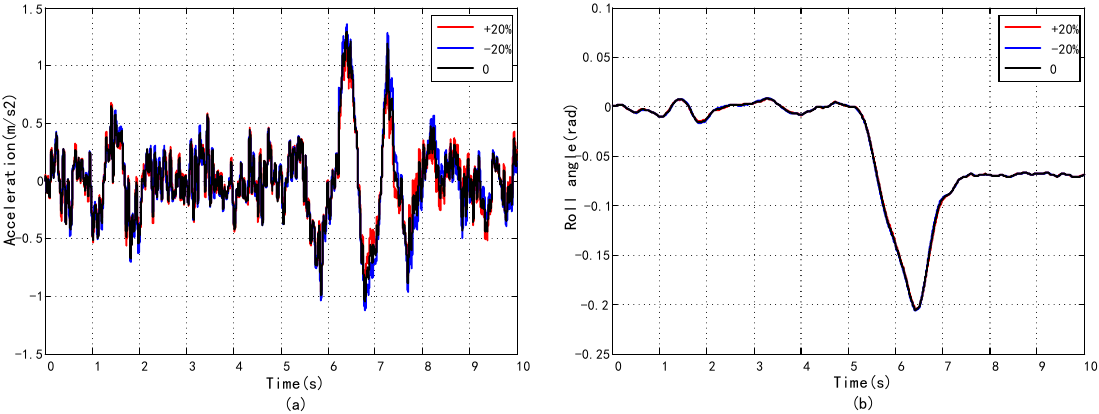
Figure 18. The robustness simulation curves with the uncertainty of suspension damping: ( a ) the vehicle body vertical acceleration in time domain; ( b ) the roll angle acceleration in time domain.